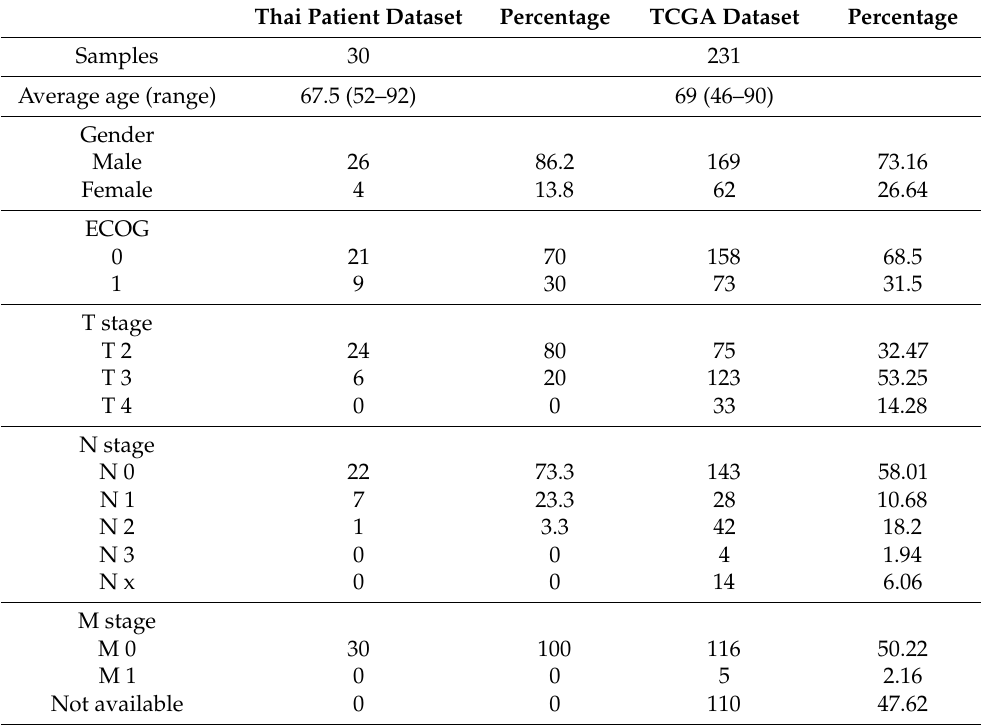
Table 1. Clinical data summary of studied MIBC